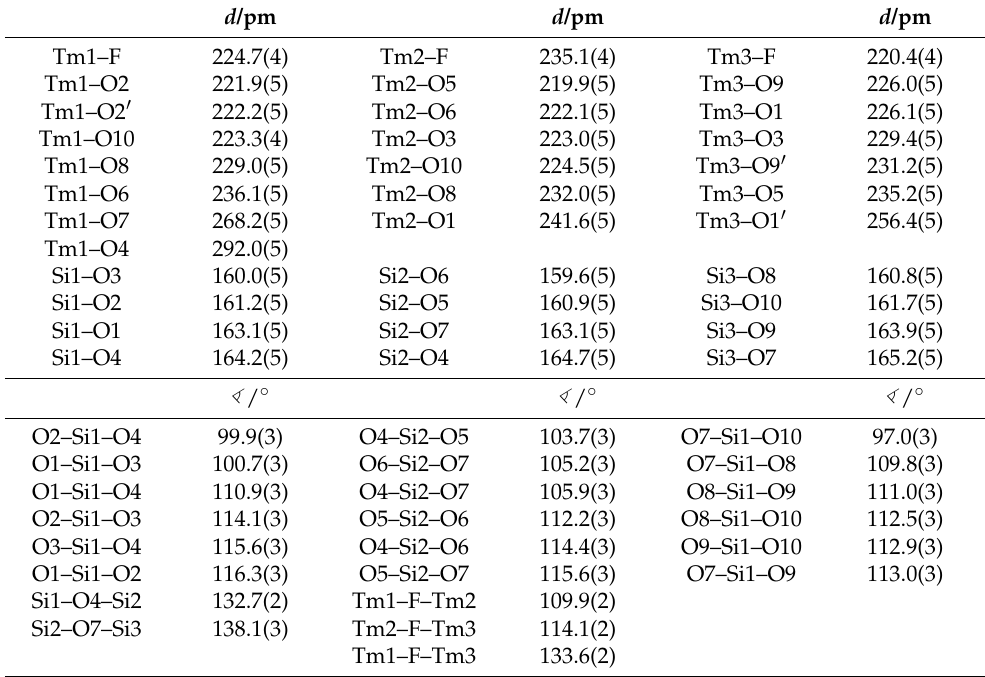
Table 3. Selected interatomic distances ( d /pm) and bond angles ( ∢ ) for Tm 3 F[Si 3 O 10 ].